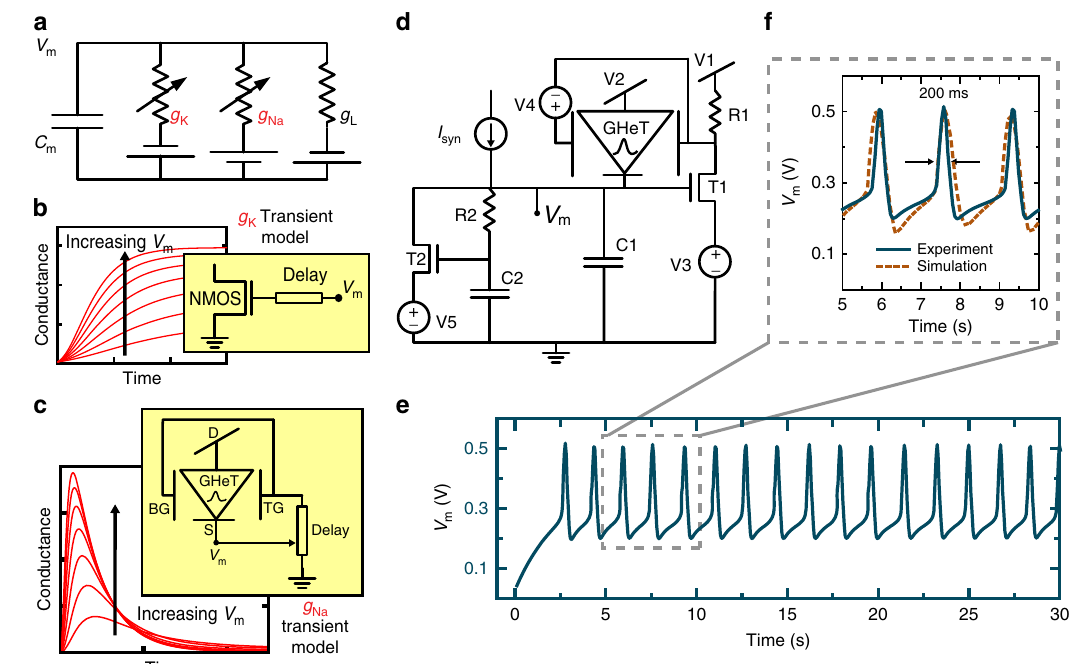
Fig. 4 Hodgkin-Huxley spiking neuron using a Gaussian heterojunction transistor. a Circuit-level equivalent of the Hodgkin-Huxley model. b Temporal evolution of g K , which can be represented by the delayed turn-on of an NMOS transistor. c The more complex transient behavior of g Na , which can be mimicked using the antiambipolar characteristics of the GHeTs. d Full circuit diagram for the experimental spiking neuron. e Experimental results for the fi rst 30 sec based on the GHeT neuron circuit detailed in d . f From dashed region in e the neuron spike FWHM is measured to be ~200 ms. Simulations (dashed brown) of the GHeT neuron circuit agree well with the experimental results. All measurements were performed in ambient conditions at room Figure 4d details the full circuit used for the experimental spiking neuron demonstration based on a single MoS 2 -CNT GHeT device, n-type fi eld-effect transistors (T1 and T2), and a